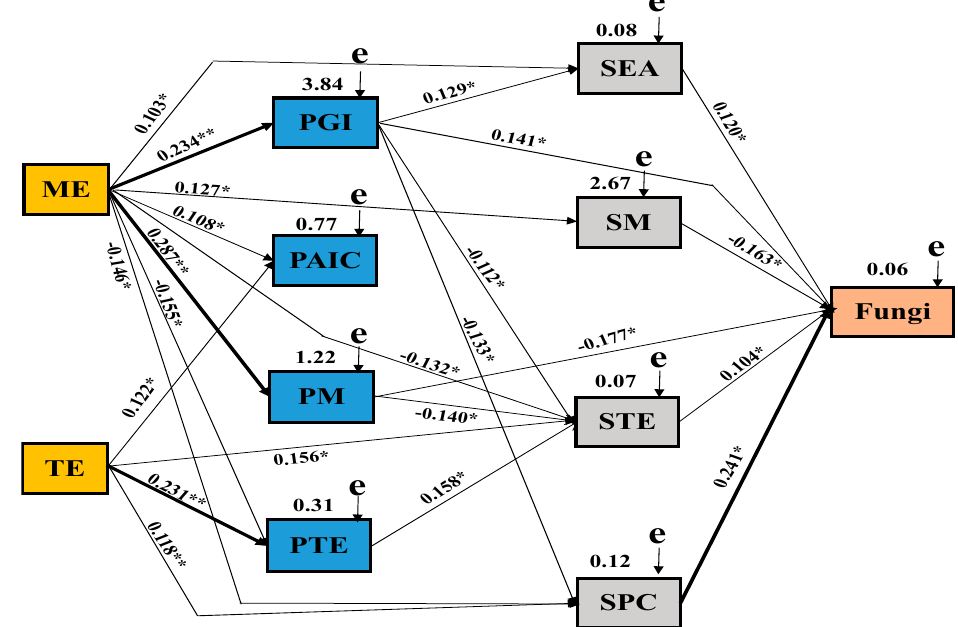
Figure 9. Structural equation model(SEM) showing the causal relationships among macroelement foliar fertilizer, microelement foliar fertilizer, plant growth indicators, chemical composition parameters, and soil parameters and soil fungi. The final model fitted the data well: maximum likelihood, X 2 = 58.227, df = 11, p = 0.008, goodness of fit index = 0.599, Akaike information criteria = 158.127, root mean square error of approximation = 0.259. Solid lines and dashed lines indicate significant and non-significant pathways, respectively. The width of the solid lines indicates the strength of the causal effect, and the numbers near the arrows indicate the standardized path coefficients (* p < 0.05 and ** p < 0.01). MAE, macroelement foliar fertilizer; MIE, microelement foliar fertilizer; PGI: plant growth parameters; PAIC, plant active ingredients; PMA, plant macroelements; PMI, plant microelements; SEA, soil enzyme activity; SMA, soil macroelements; SMI, soil microelements; SPC, soil physicochemical properties; Fungi, soil fungi.